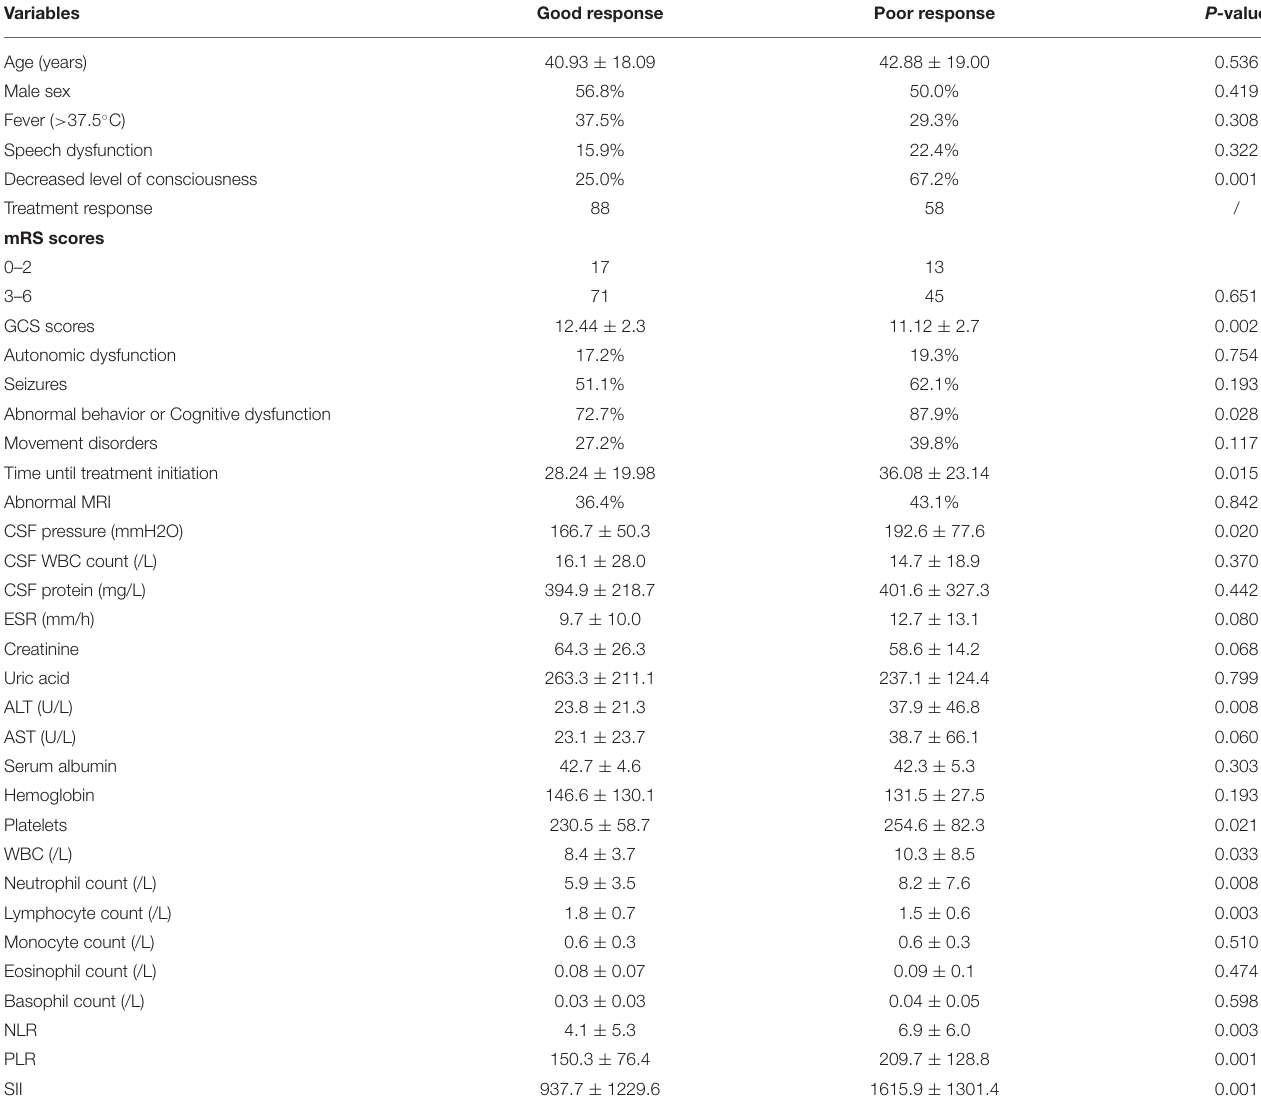
TABLE 1 | Comparison of baseline characteristics of patients with different treatment